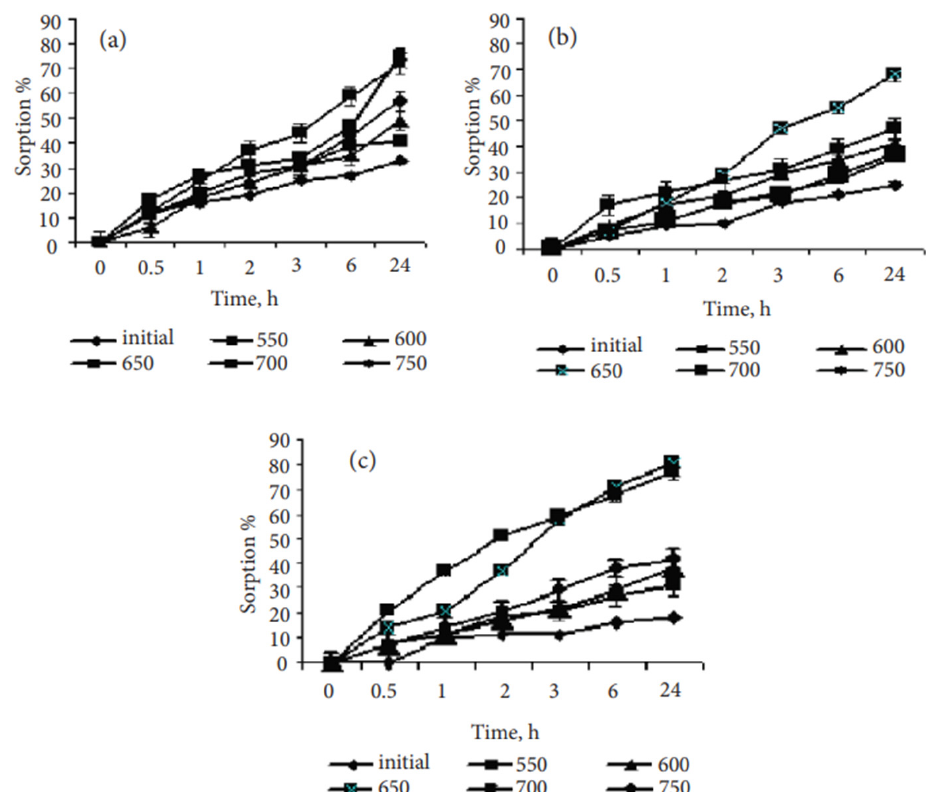
Figure 16. Dynamics of sorption of Rhodotorula glutinis var. glutinis ( a ), Pseudomonas mendocina ( b ) and Pseudomonas aeruginosa ( c ) cells onto the surface of initial and carbonized AS. Reprinted with permission from Ref. [50]. Copyright 2020, Jenny Stanford Publishing Pte. Ltd.